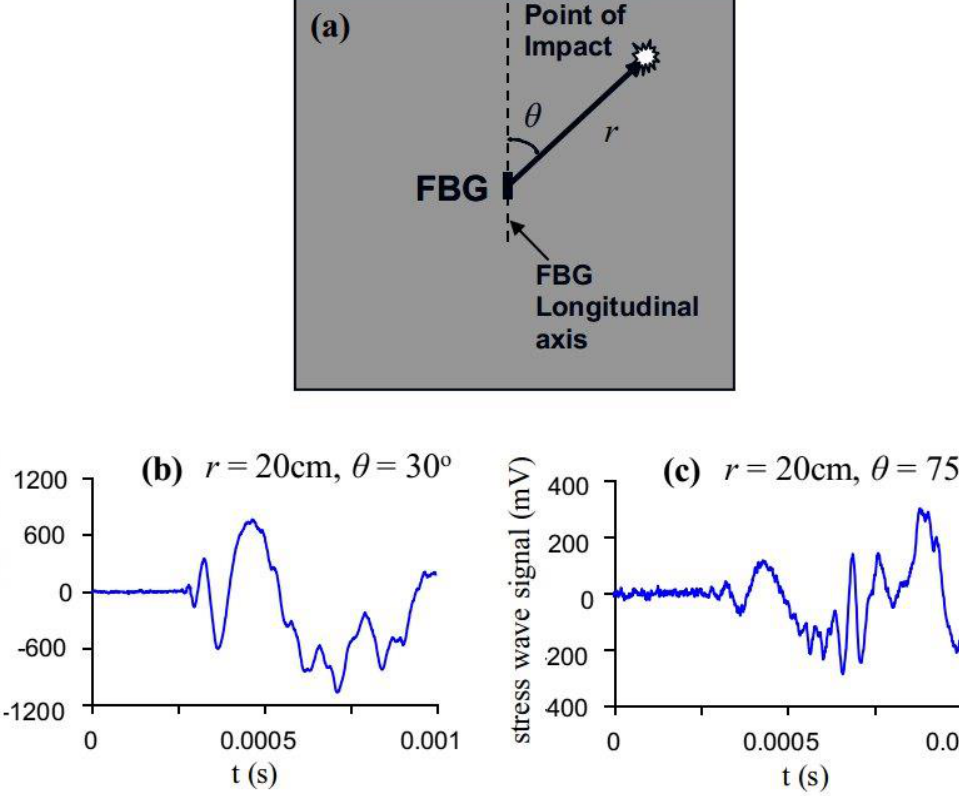
Figure 1. ( a ) Experimental setup for evaluating sensitivity under di ff erent ( r , θ )’s; ( b ) received waveform for impact at r = 20cm, θ = 30°;( c ) received waveform for impact at r = 20cm, θ = 75°.